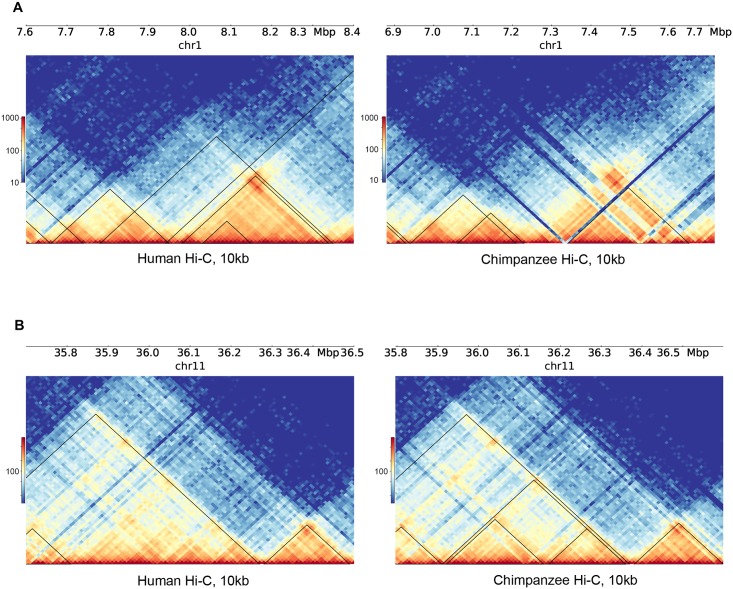
Examples of conserved and divergent TADs.(A) A region on chromosome 1 with examples of both conserved and divergent Arrowhead [62] TAD inferences (black lines). Both the larger TADs seen in the chimpanzee map (right) appear to be conserved in the human map (left), whereas several of the TADs inferred in the human map are noticeably absent from the chimpanzee map. (B) A region on chromosome 11, once again showing examples of conserved and divergent Arrowhead TAD inferences (black lines). All the TADs seen in the human map (left) appear conserved in the chimpanzee map (right), whereas three smaller TADs inferred in the chimpanzee map are not found in the human map, suggesting divergence.